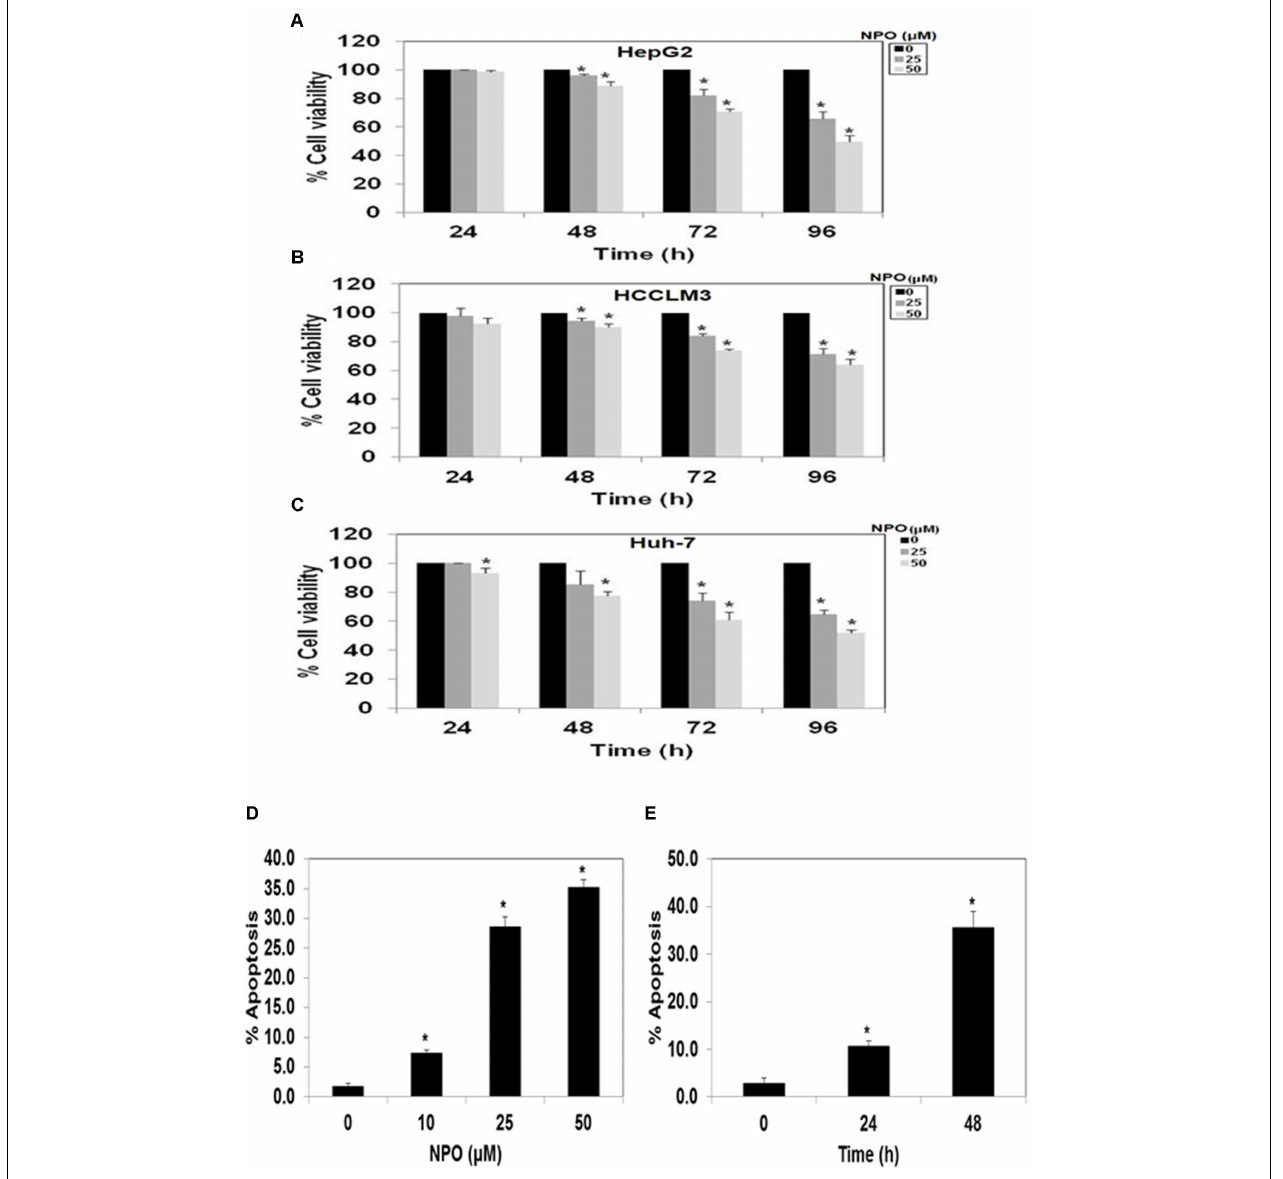
FIGURE 2 | (A–C) NPO the lead compound significantly inhibits the viability of various HCC cells lines. NPO was identified as lead anticancer agent among the structural variants and NPO decreased the growth of HepG2, HCCLM3 and Huh-7 cells in dose- and time-dependent manner. (D) and (E) , NPO can induce apoptosis in a dose and time-dependent manner in HCCLM3 cells. ∗ p <